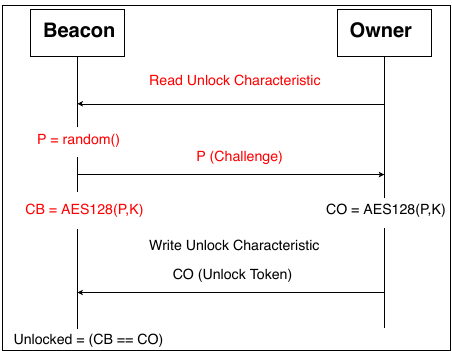
Figure 21: Unlock scheme used by Google Eddystone Beacons. Note that a non- authenticated device can trigger encryptions with known plaintext by reading the unlock characteristic (steps marked in